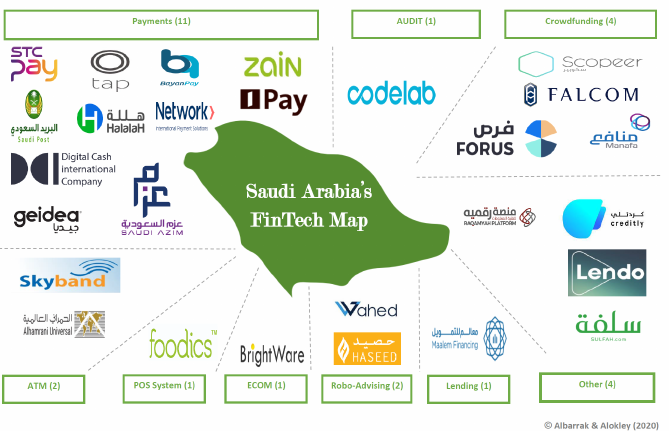
Figure 1. FinTech startups in Saudi Arabia by